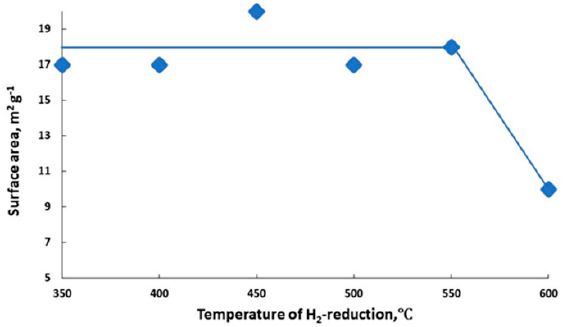
Figure 12. Effect of reduction temperature of 6%K/BaFeHAl-30 catalyst on its surface area. Figure 12. E ff ect of reduction temperature of 6%K / BaFeHAl-30 catalyst on its surface area. ◦ Reducing 6%K / baFeHAl-30 at 550 C increased CO capacity (Figure 8a). Thus, this catalyst